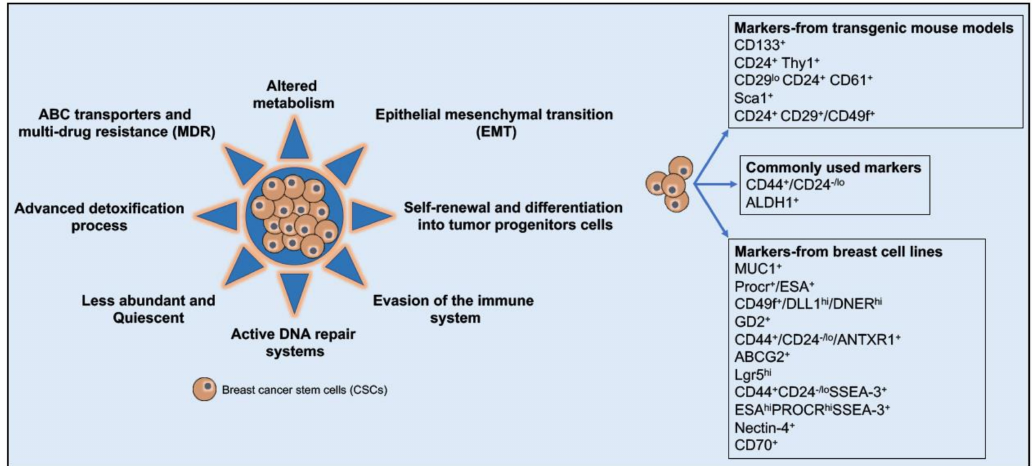
Figure 3. Specialized capabilities of breast cancer stem cells (BCSCs) include the power to resist therapeutic strategies: The less abundant (when compared to the terminally di ff erentiated breast cancer cells) BCSCs with an altered metabolism are highly capable of evading therapeutic intervention and causing a relapse of the disease by employing one or more of their capabilities such as the ability to self-renew and di ff erentiate into tumor progenitor cells, to evade the immune system, to activate unique DNA repair systems, to utilize ABC transporters for multidrug resistance (MDR) and activate advanced detoxification processes and support epithelial–mesenchymal transition (EMT). The well-studied CD44 + / CD24 neg / low marker and other markers used in the identification of BCSCs are provided in the figure